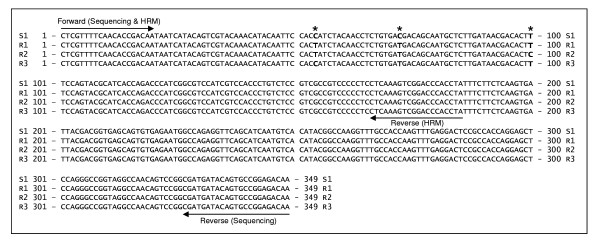
Sequence comparison of the four haplotypes detected at marker Cntg10192. Three haplotypes (R1, R2, & R3) are associated with dieback resistance while the S1 haplotype is always associated with susceptibility to the disease. Horizontal arrows indicate positions of the primers used for sequencing and for the HRM analysis. Asterisks show the positions of the three SNPs present in the marker.